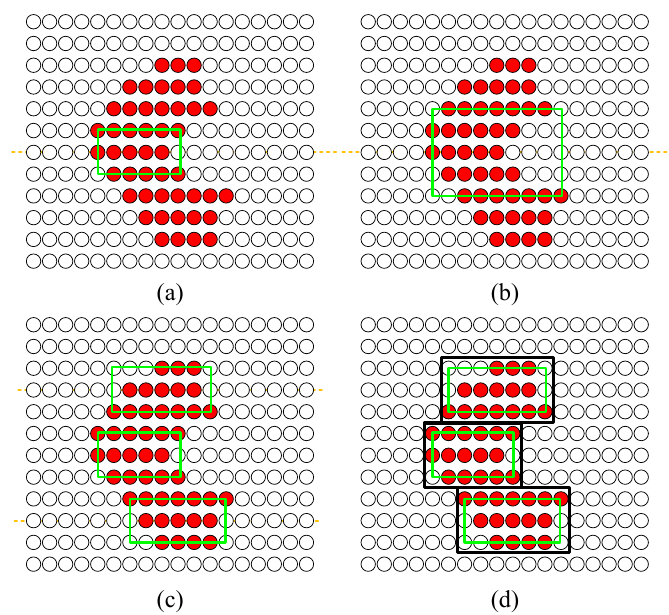
Figure 5. An example of PolyBoundingBox construction for watershed result. From ( a – d ) show the construction of PolyBoundingBox.